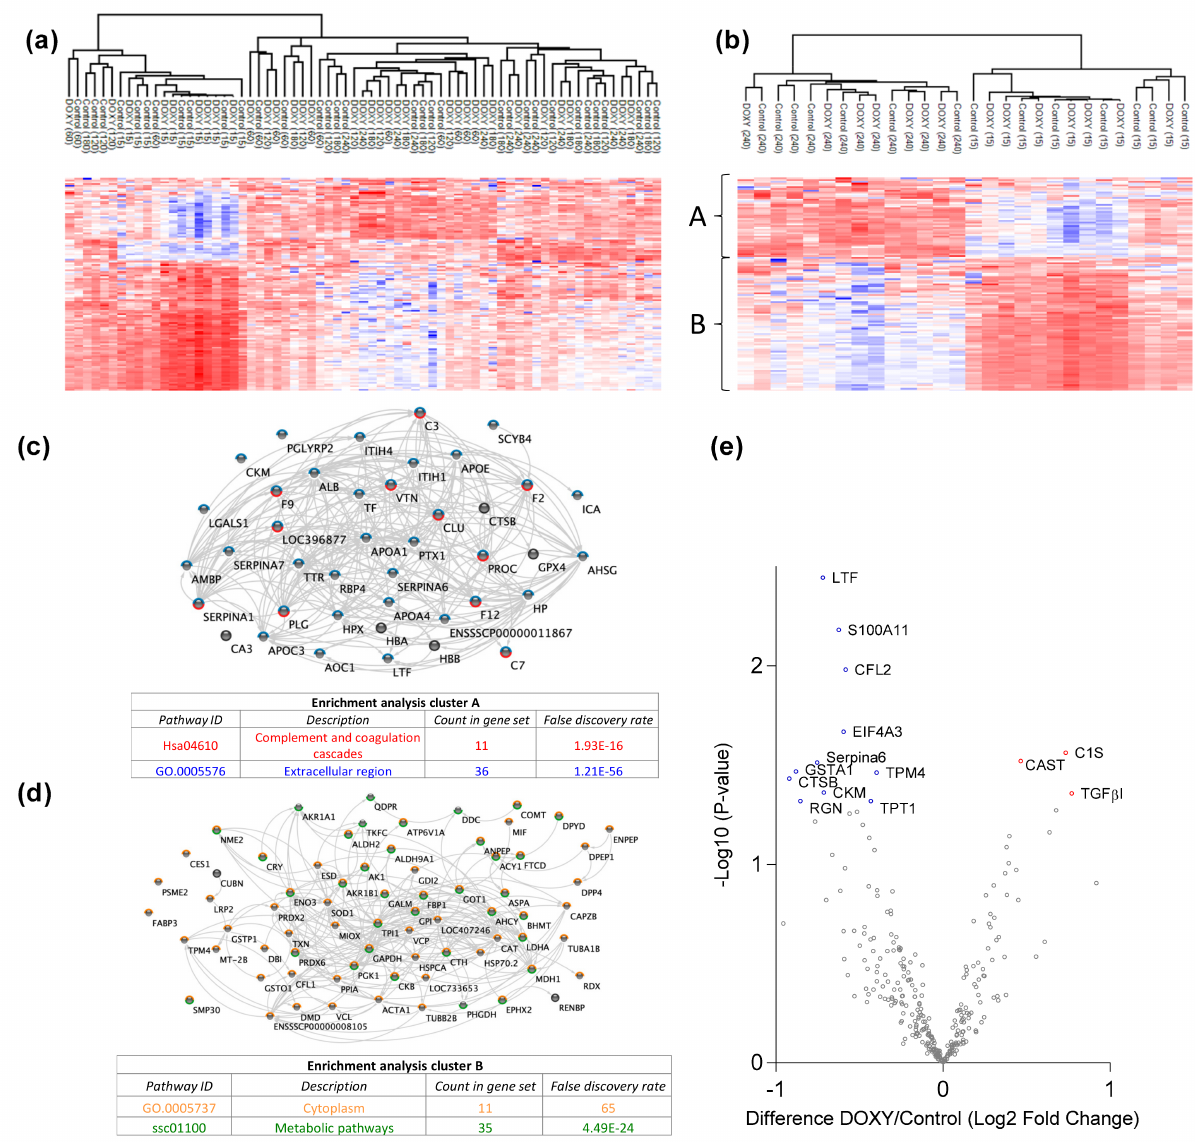
Figure 2. Urinary proteomic analysis of ex vivo reperfused kidneys revealed altered complement & coagulation, ECM and metabolic pathways. ( a ) Heat map and hierarchical clustering of proteins at T15, T60, T120, T180 and T240. ( b ) Heat map and hierarchical clustering of proteins in urine samples only at T15 (beginning) and T240 (end). Protein expression is clustered into A and B. ( c ) Gene ontology term enrichment analysis of proteins in cluster A. ( d ) Gene ontology term enrichment analysis of proteins in cluster B. ( e ) log2 Fold Change in abundance between DOXY and the control was plotted on the x -axis and the statistical significance of these changes on the y -axis as the − log10 ( p -value). DOXY: doxycycline